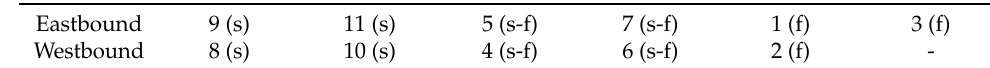
Table 8. Train entrance time